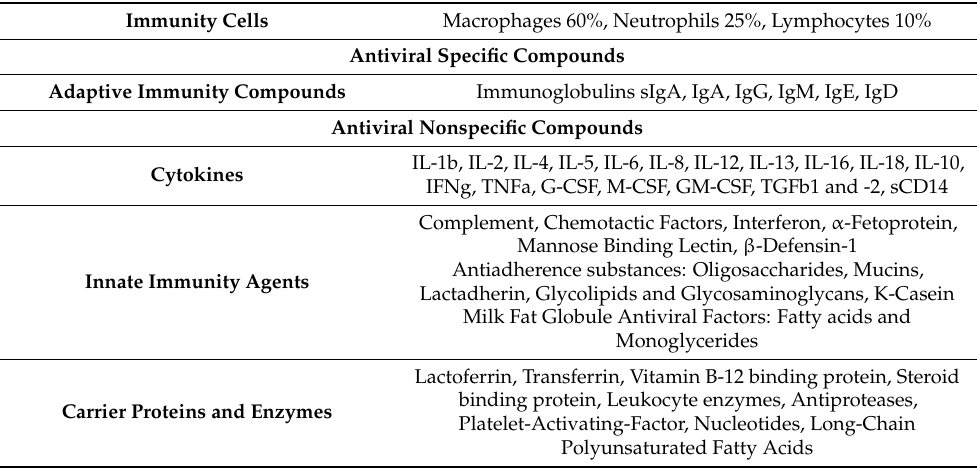
Table 1. The main groups of antimicrobial compounds in human